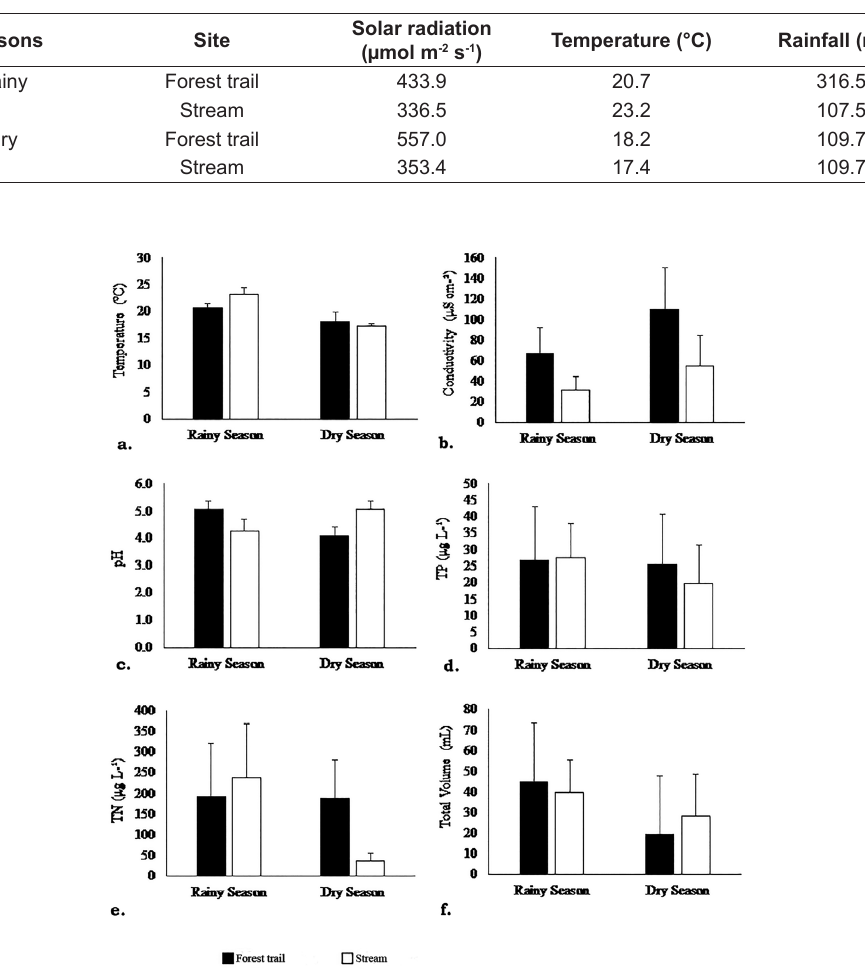
Figure 2. Temperature (a), electric conductivity (b), pH (c), total phosphorus (d) and nitrogen (e) concentrations and total volume (f) (Means; ±SD; N = 12) in the phytotelmata of Nidularium longiflorum at the forest trail and stream in rainy and dry seasons.